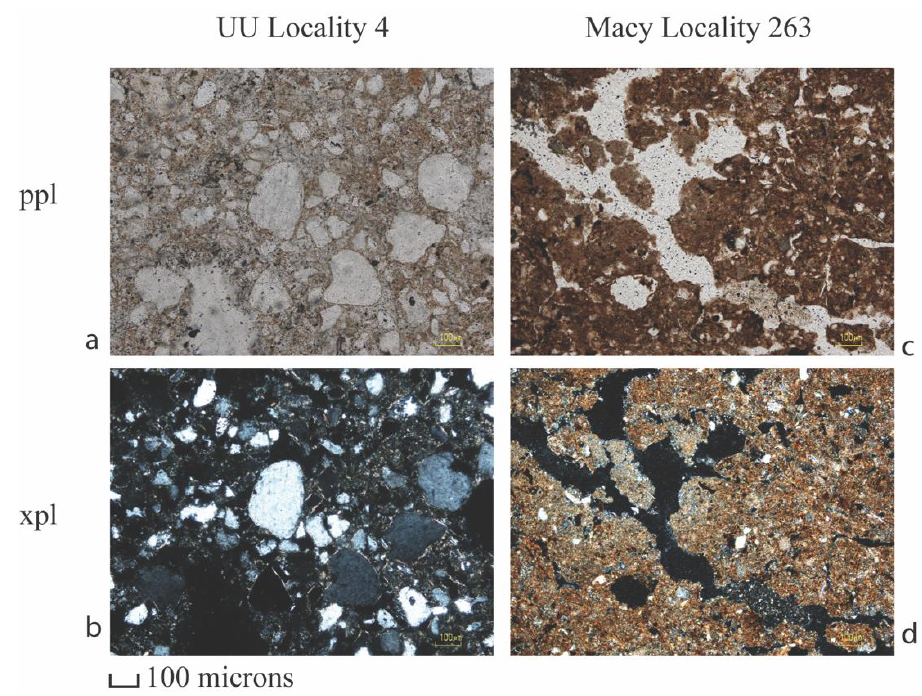
Figure 4. Petrographic images demonstrating micromorphological characteristics in the UU soil (UU Locality 4, photos ( a , b ), and the late-Holocene pedocomplex of soils (Macy Locality 263, photos ( c , d ) identified in the terrace remnants of the South Fork River within the eastern escarpment breaks of the Southern High Plains, Texas. ( a ) 10 × magnification in plane polarized light. ( b ) 10 × magnification in cross polarized light. ( c ) 10 × magnification in plane polarized light. ( d ) 10 × magnification in cross polarized light.